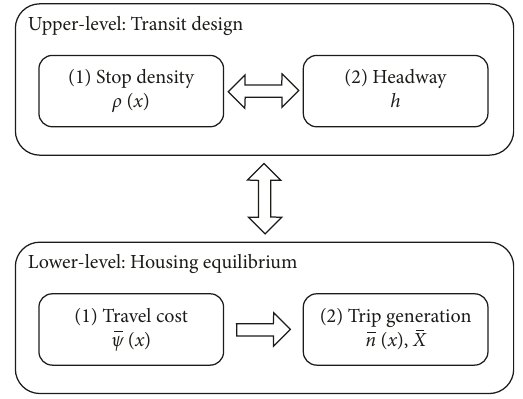
Figure 1: Flowchart of the bilevel solution